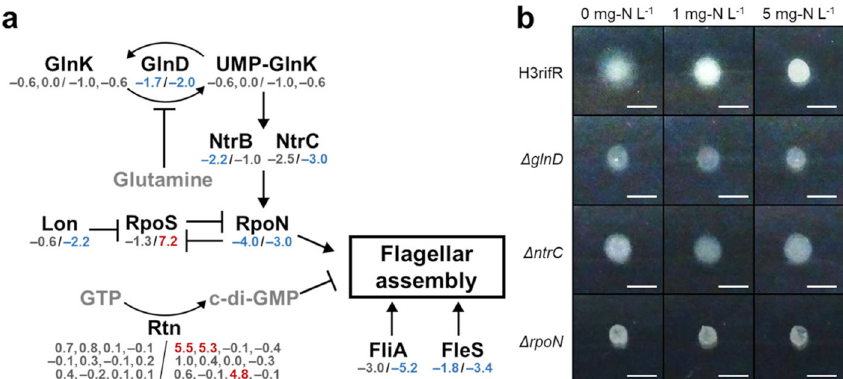
Fig. 4 Signaling genes for fl agellar motility are critical for ef fi cient colonization and fi tness. a Predicted signaling network for fl agellar assembly of Aquitalea magnusonii H3. Values below protein names represent the effects on colonization/ fi tness ability (Log 2 Plant/Control; values before and after slash represent the results after 3-h and 7-d experiments, respectively; Fig. 2) of corresponding genes. Depleted and enriched genes are shown in blue and red, respectively b The hypermotile phenotype of strain H3rifR (parental strain) under nitrogen starvation and the loss of this response upon mutation in the signal cascade. The cell suspension was spotted on a soft agar plate with different nitrogen concentrations, and colony expansion was observed after 8 h. Scale bar represents 5 mm. Supplementary Data 9 shows the list of depleted and enriched genes in this fi gure.